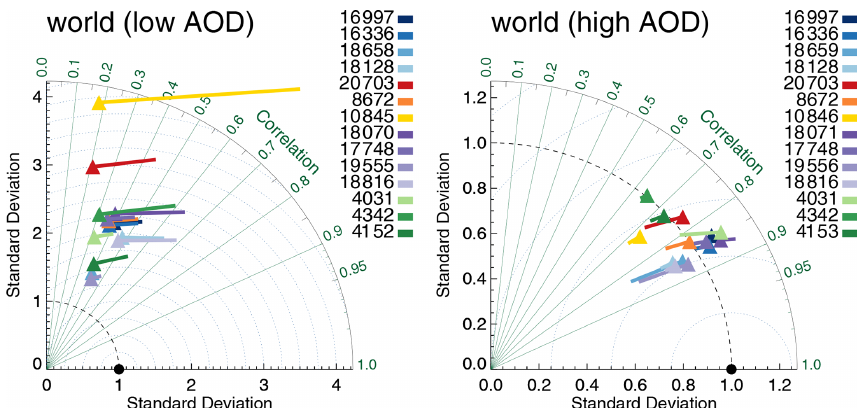
Figure 5. Taylor diagram for satellite products evaluated with AERONET at either low or high AOD (distinguished by median AERONET AOD ∼ 0 . 12). Symbols indicate correlation and internal variability relative to AERONET; the line extending from the symbol indicates the (normalized) bias (see also Sect. 3.1). Colours indicate the satellite product (see also Fig. 1); numbers next to coloured blocks indicate the amount of collocated data. Products were individually collocated with AERONET (Kinne et al., 2013, selection, pruned) within 1h.